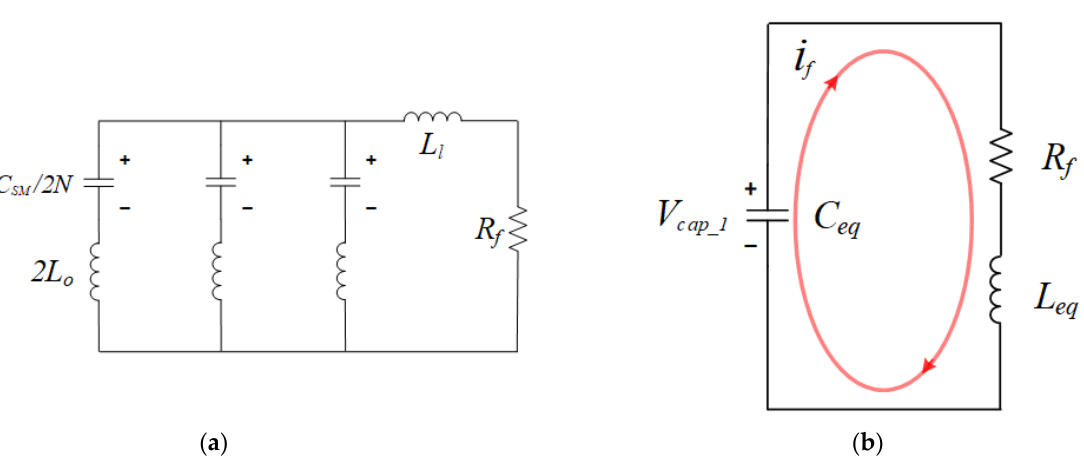
Figure 9. Equivalent circuit of the MMC before sub-modules are turned off in case of ( a ) three phases; ( b ) a simplified circuit.